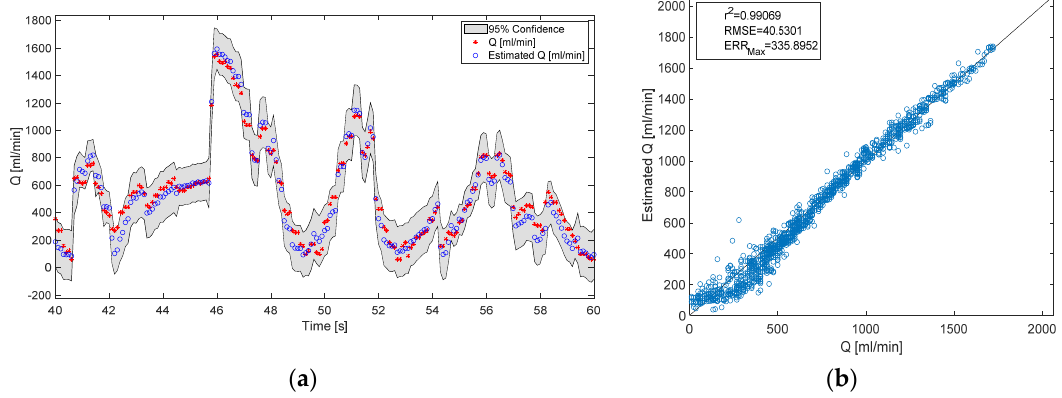
Figure 5. Results of the flow rate prediction. The estimation is done with a model that is trained on the same viscosity as the test signal. (a) Time series of the true and predicted flow rate with confidence intervals; (b) A scatter plot with fitness measures of the estimated vs measured flow rate.